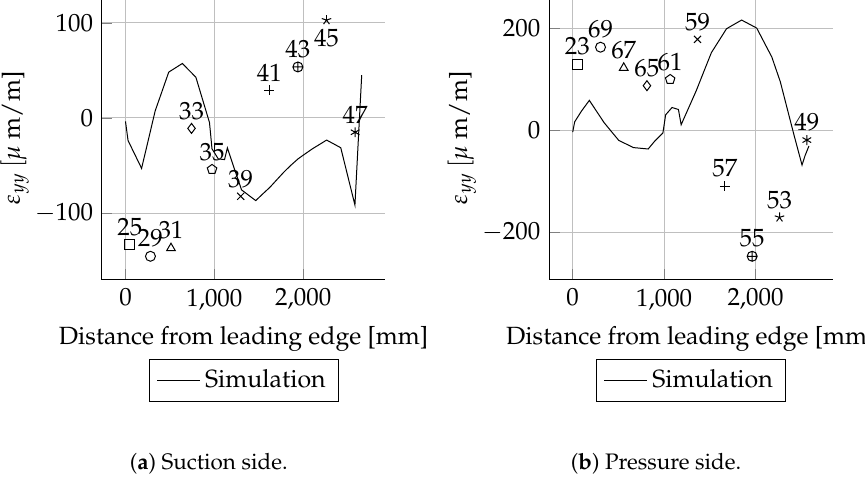
Figure A55. Strain comparison ε TT at radial position R = 5000mm for torsion load case LC_1.